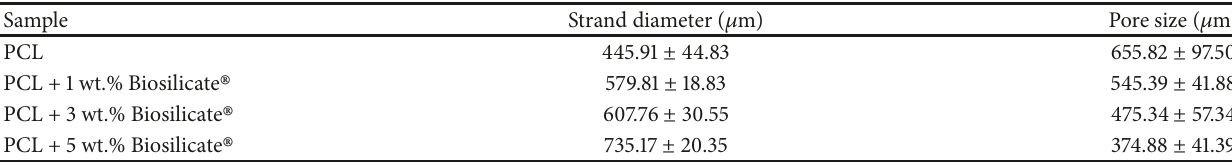
Table 1: Mean extruded strand diameter and mean pore